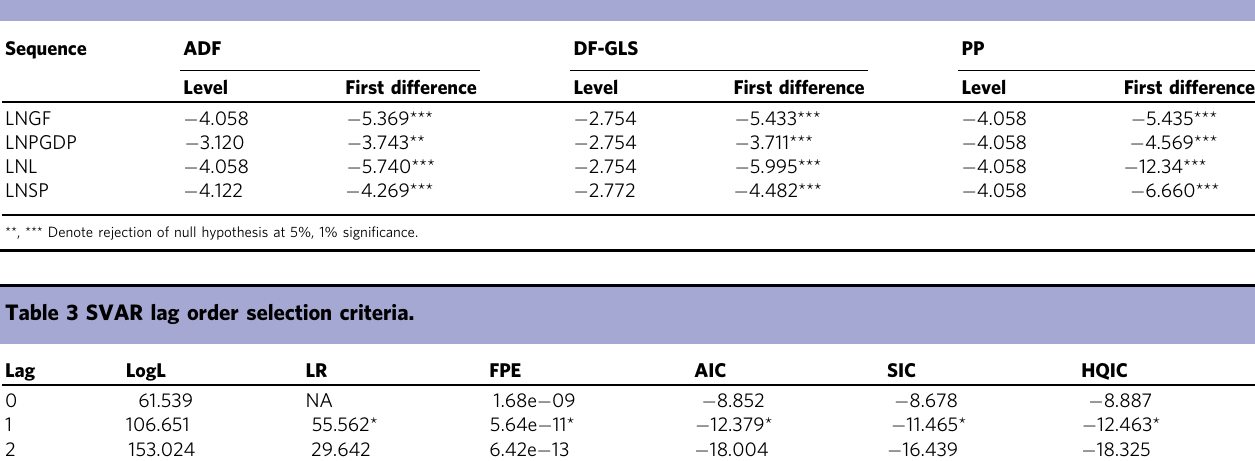
Table 2 Unit root test results.